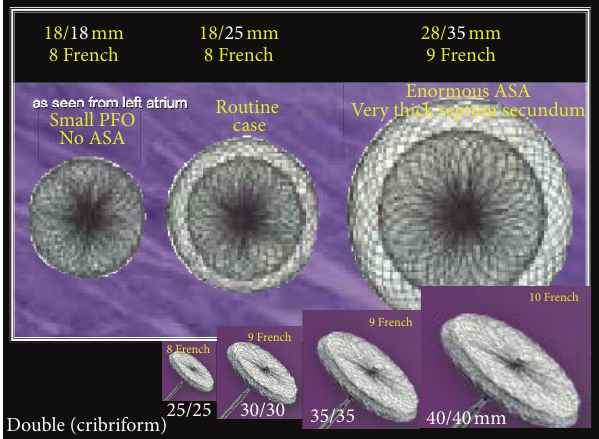
Figure 2: Family of Amplatzer PFO occluders. The right/left numbersindicatethediametersoftheleftandrightdisk,respectively (different in some devices). The French size indicates the minimal inner lumen of the required sheath (1F = 0.3 mm). The double (cribriform) occluders are also predestined for cribriform atrial septal